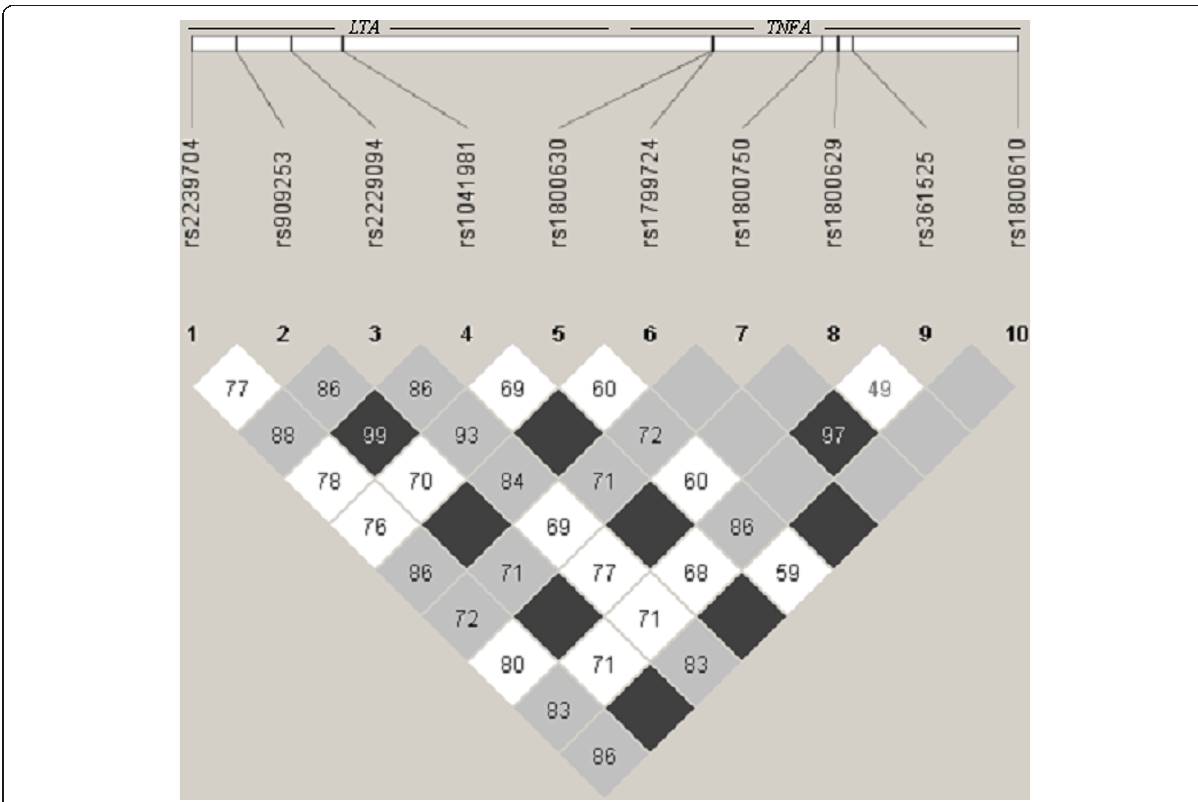
Figure 1 Pairwise linkage disequilibrium between SNPs in the LTA and TNFA genes . Values provided in each box, were estimated as r 2 using Haploview 3.2. Dark grey regions depict strong LD (1.0), pale grey and white regions represent low